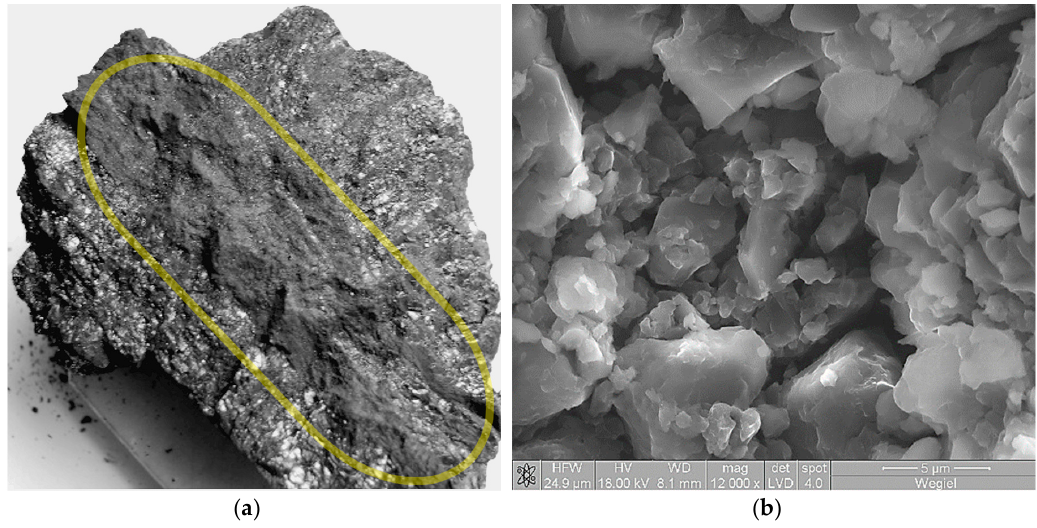
Figure 2. A piece of coal from the post-outburst mass from the Zofiówka coal mine with a cataclastic band in the middle ( a ); SEM image of cataclastic coal from the Zofiówka coal mine—magnification 12,000× ( b ).